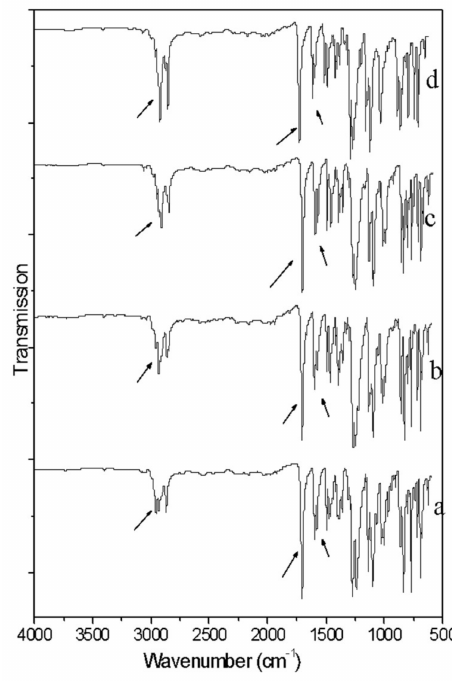
Figure 2. FTIR spectra of compound 2a–d.